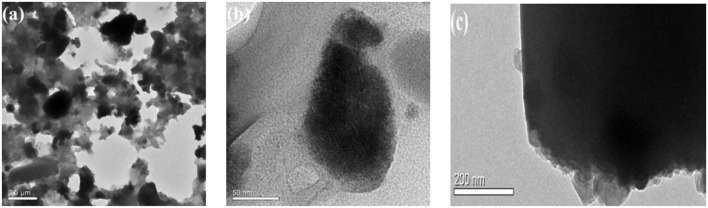
(a–c) Typical TEM images of the Sn1.5PW/Cu-BTC-1 hybrids.